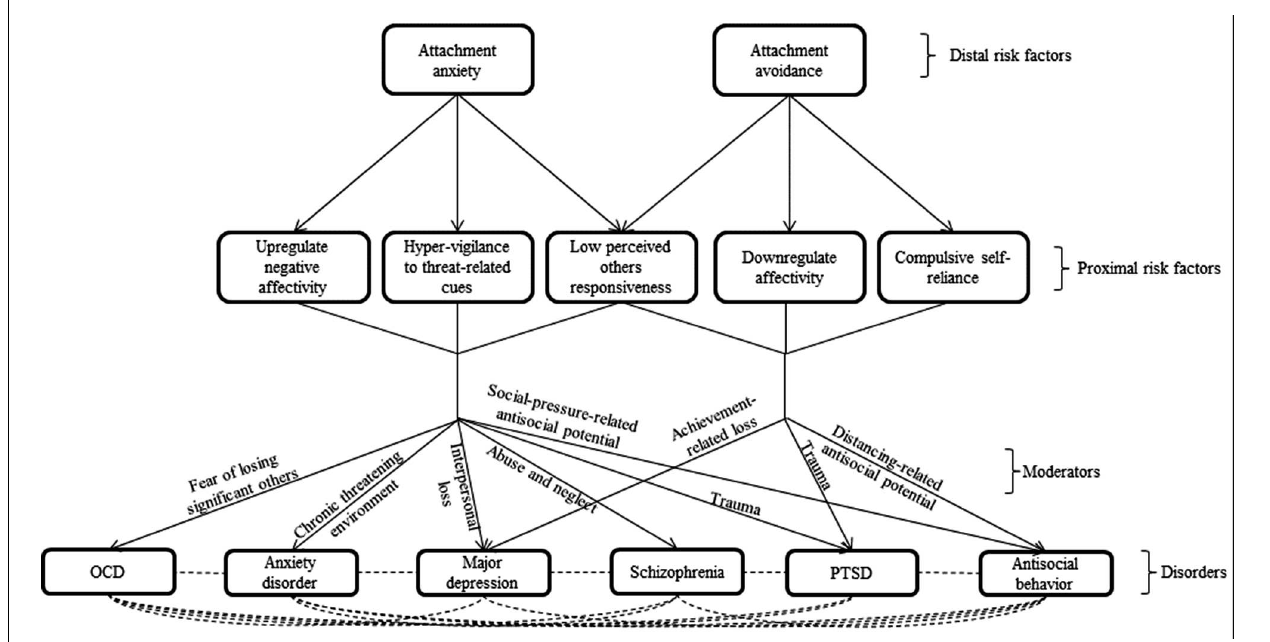
FIGURE 1 | In this transdiagnostic model, attachment dispositions serve as distal risk factors for multiple psychopathological disorders. Each disposition affects a triad of proximal risk factors, which mediate the effect of attachment anxiety and avoidance on psychopathology. Specific moderators determine the divergent trajectories that individuals high on the proximal risk factors may